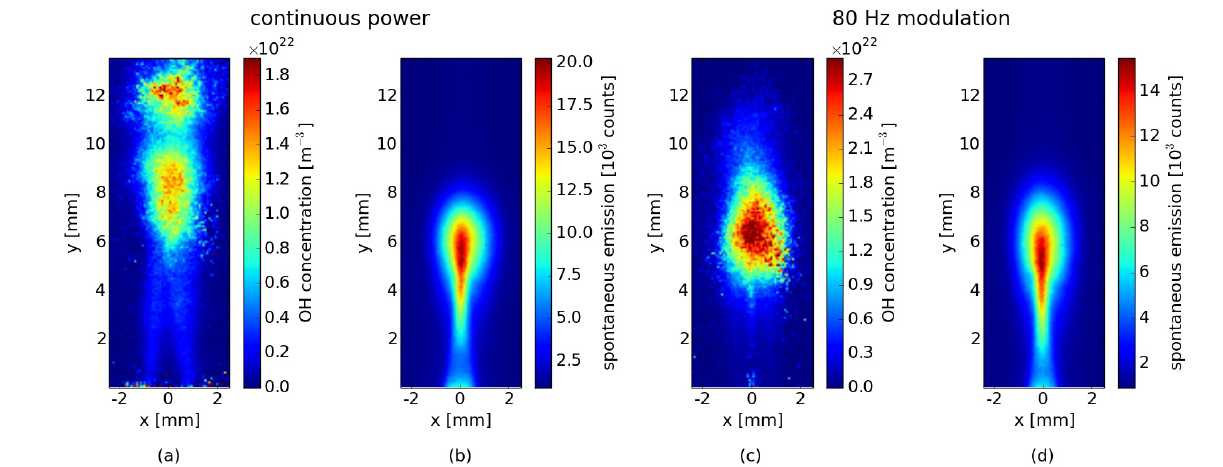
Figure 2 : OH concentration and spontaneous emission of the surfatron discharge for constant MW input power (on the left) and MW input power modulated by 80 Hz (on the right).